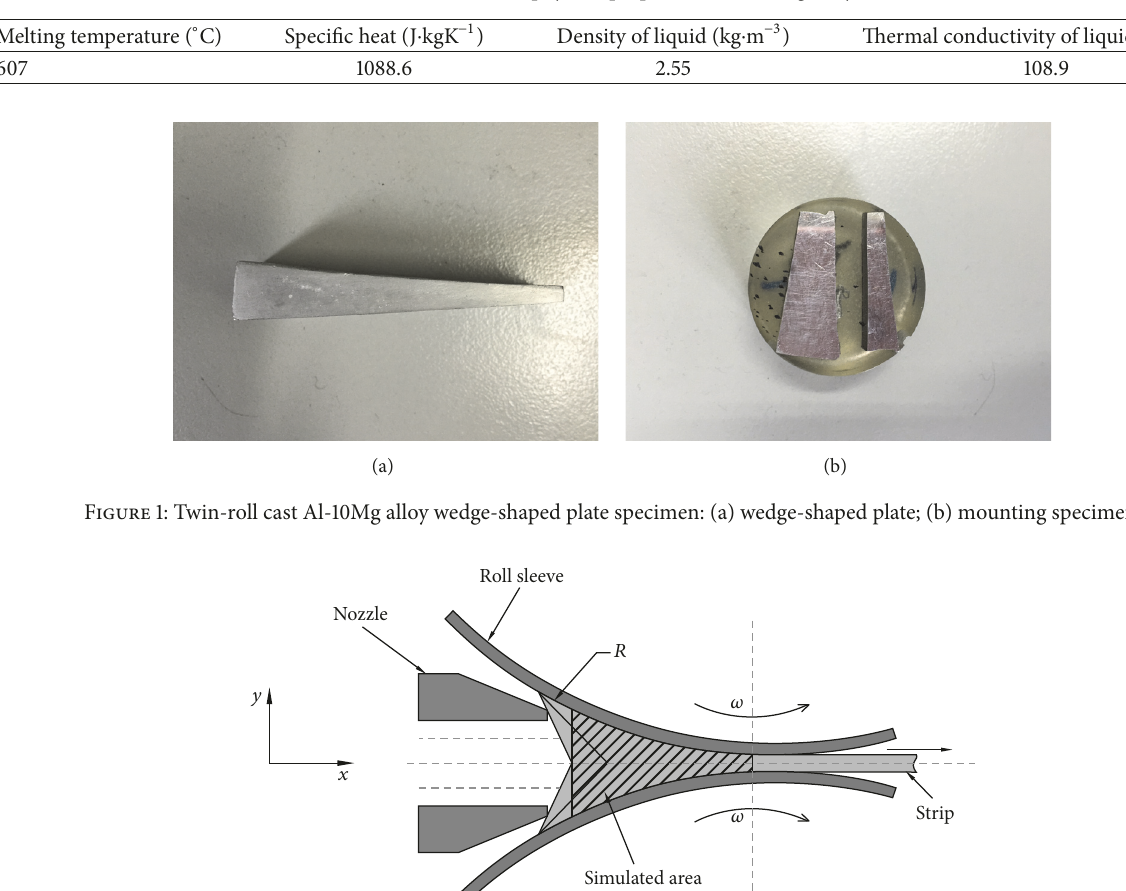
Table 2: Thermal physical properties of Al-10Mg alloy.